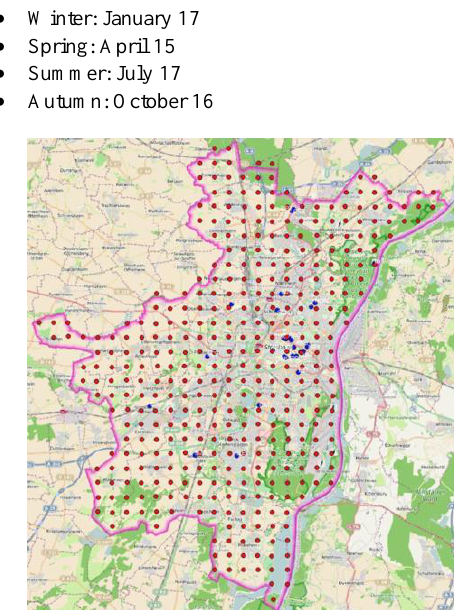
Figure 5 . Grid of 444 points for which LST and LCZ data was analysed.